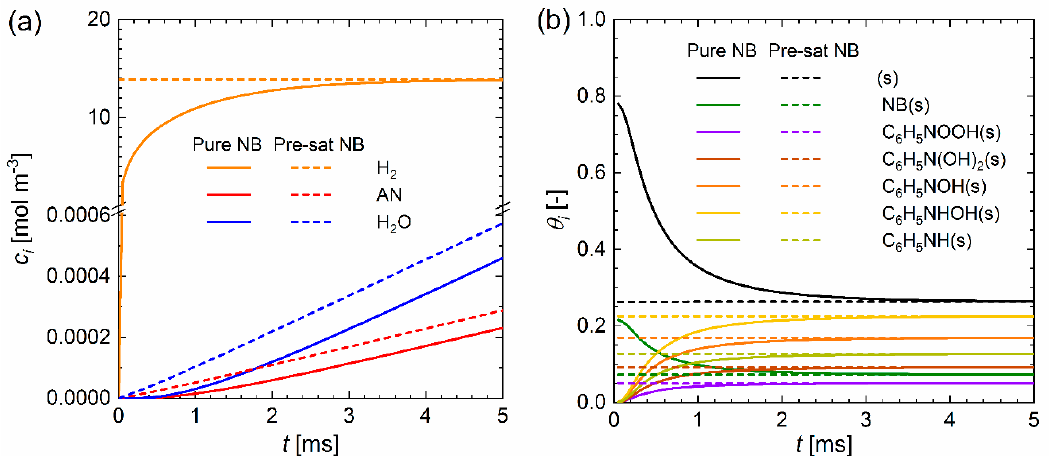
Figure 9. Time evolutions of mean concentrations of bulk species ( a ) and mean site fractions of surface species ( b ). Solid lines represent the initial condition of liquid as pure nitrobenzene, while dashed lines represent the case initialized with nitrobenzene pre-saturated with hydrogen.